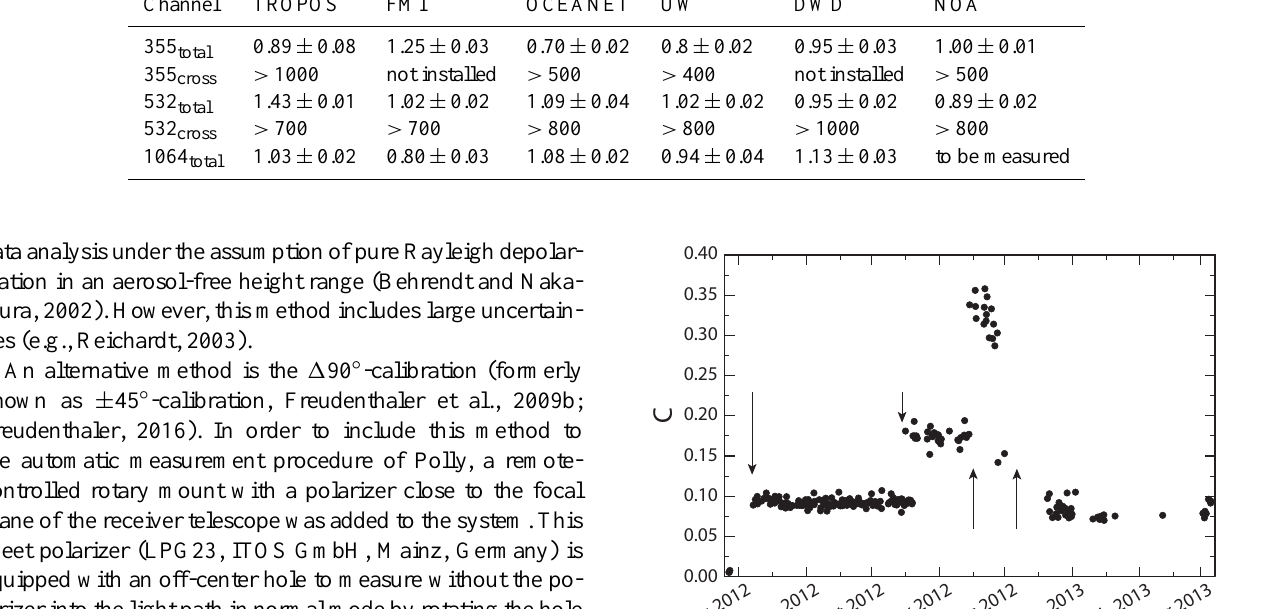
Table 4. Ratios of polarization-dependent receiver efficiencies R i for the elastic channels of different Polly XT systems. Channel